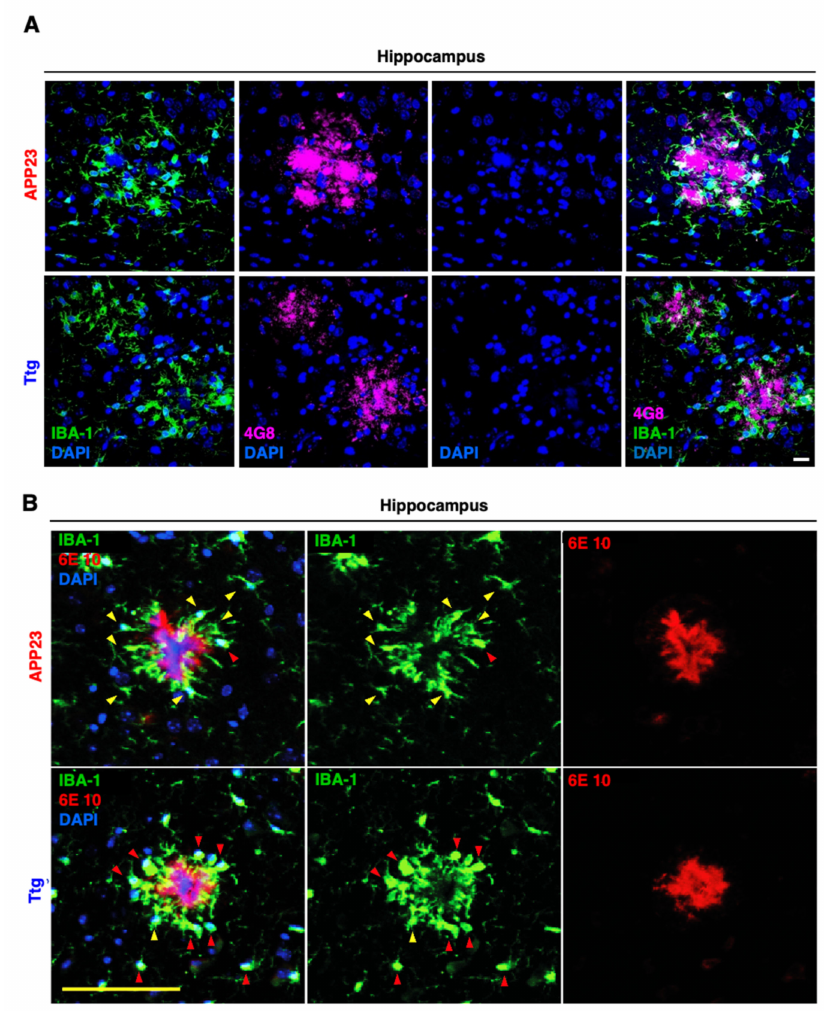
Figure 7. Ttg mice display a phagocytic-proficient Iba1-positive microglia morphology surrounding A β plaques. ( A ) Representative panel depicting IF staining of microglial cells (IBA-1 in green) surrounding A β plaques (in magenta). Plaques stained with the 4G8 antibody appear more dissolved and smaller in the Ttg mice compared to the APP23 littermates. Scale bar = 20 µ m. ( B ) Representative panel depicting different microglia morphology in Ttg mice compared to APP23 mice. Microglial cells (IBA-1 in green) surrounding the plaques (6E10 in red) appear more rounded and amoeboid, with a compact structure (red arrowheads) in Ttg animals compared to APP23 littermates, suggesting enhanced phagocytic activity. In the APP23 group, the yellow arrows indicate a filamentous microglia shape with a less compact structure. Nuclei are labeled with DAPI (blue). Scale bar = 100 µ